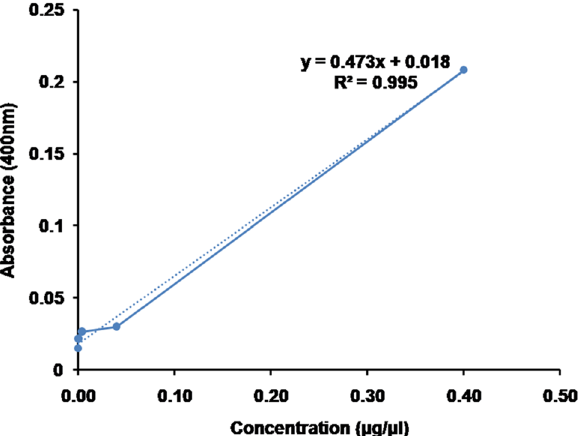
Figure 3. Calibration curve of amplification intensity in terms of absorbance at different input template